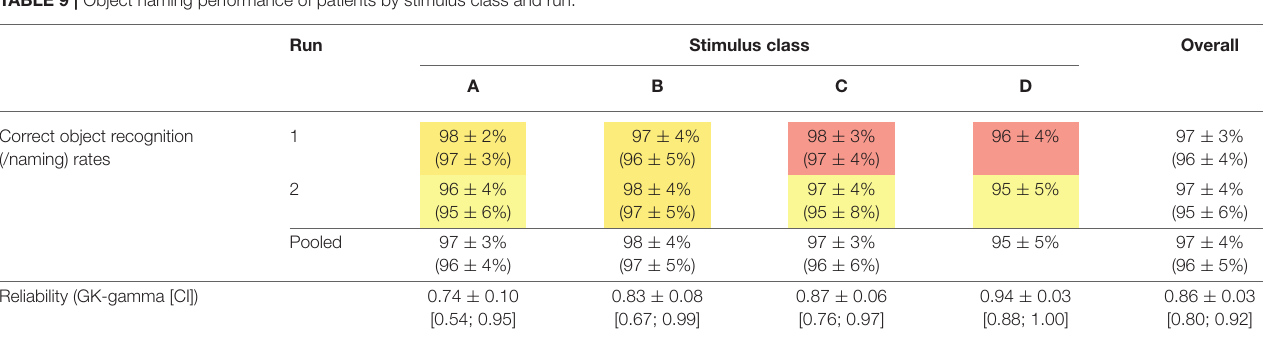
TABLE 9 | Object naming performance of patients by stimulus class and run. Run Stimulus